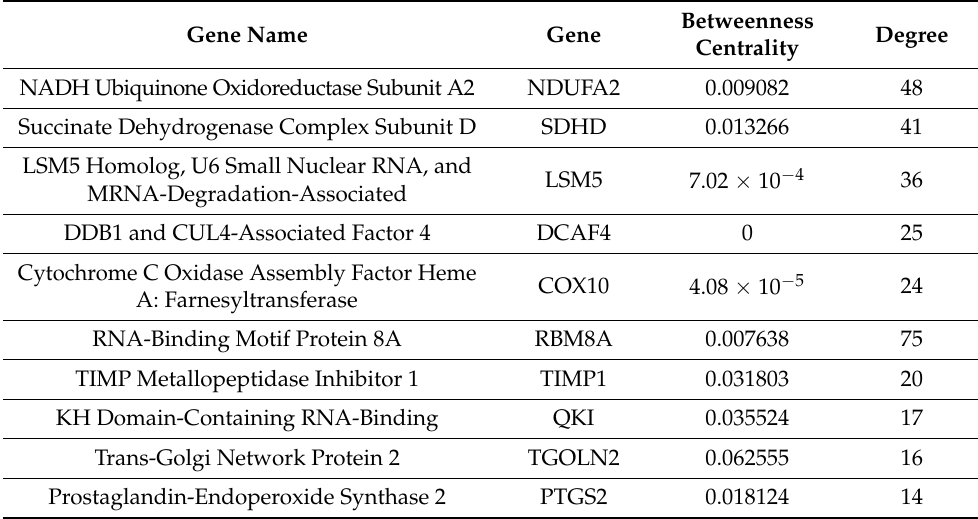
Table 2. Top DEGs that had interactions in the protein–protein interaction (PPI) network (GSE62080 database).